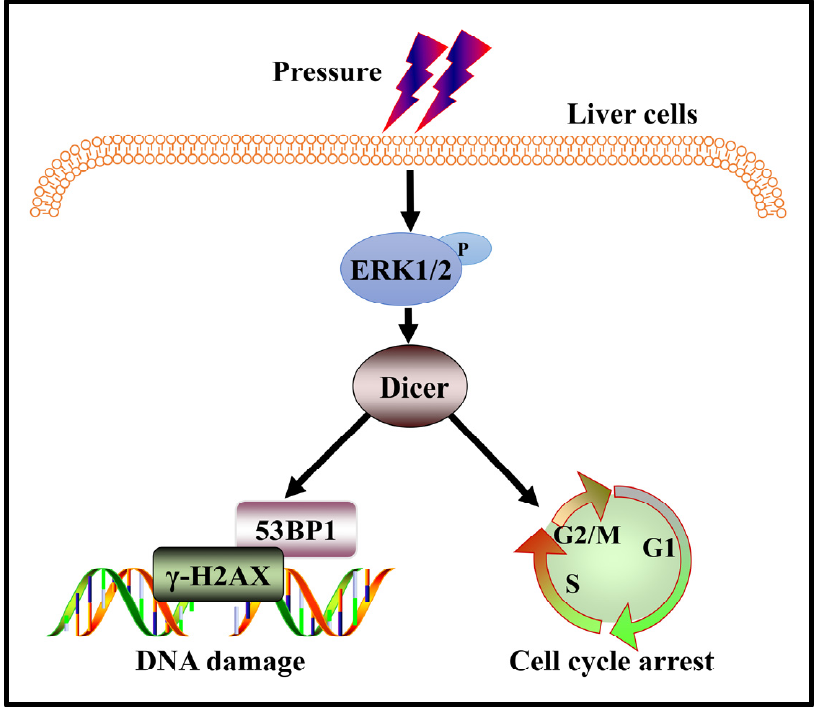
Figure 7. Schematic model of DNA damage induced by higher pressure in hepatocytes. Higher stress results in aggravated DNA damage in hepatocytes. Higher pressure activates ERK1/2 and upregulates the expression level of Dicer. Then, Dicer mediates the DDR of the cell. After Dicer expression downregulation, the DDR function of the cells is diminished, and the DNA damage of the cells is enhanced in response to stress .